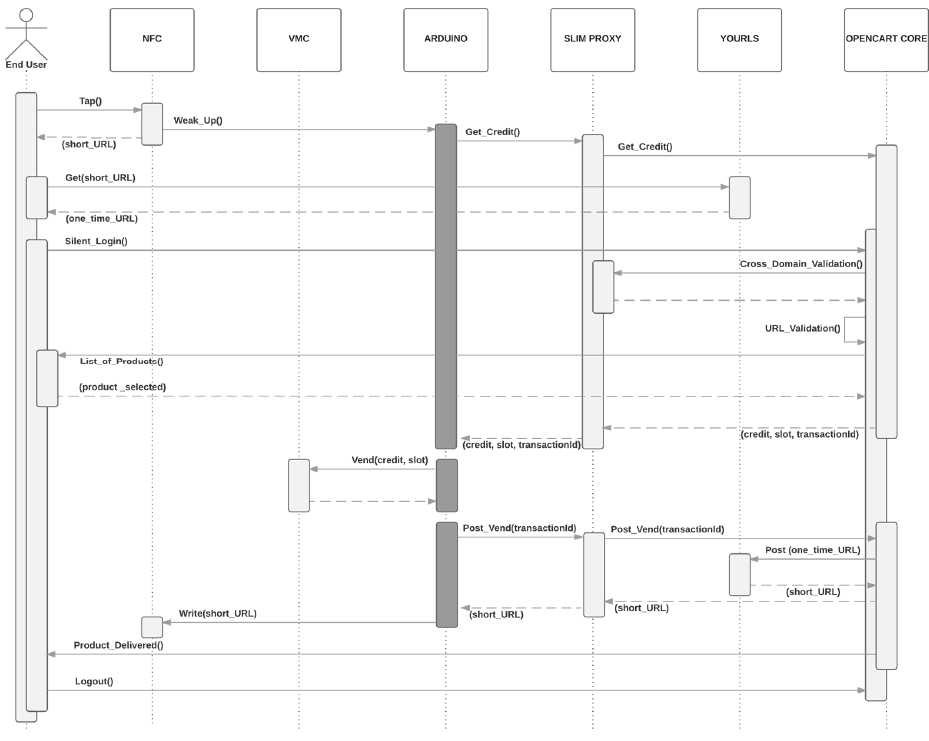
Figure 8. Call flow example of usage of one-time URL in a vending machine.